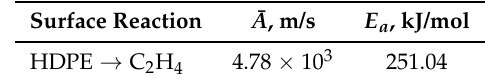
Table 1. Arrhenius rate constants from curve fitting for HDPE [34].